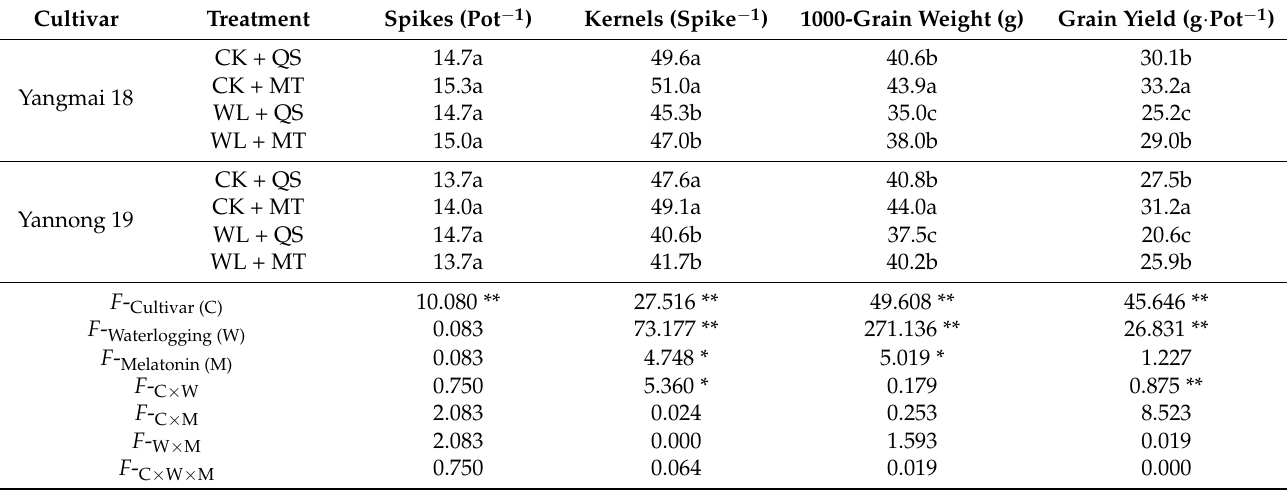
Table 4. Grain yield and its components under different treatments, i.e., CK + QS: leaf spraying with distilled water under non-waterlogged conditions; CK + MT: leaf spraying with 100 µ mol · L − 1 of melatonin under non-waterlogged conditions; WL + QS: leaf spraying with distilled water under waterlogged conditions; WL + MT: leaf spraying with 100 µ mol · L − 1 of melatonin under water- logged conditions.